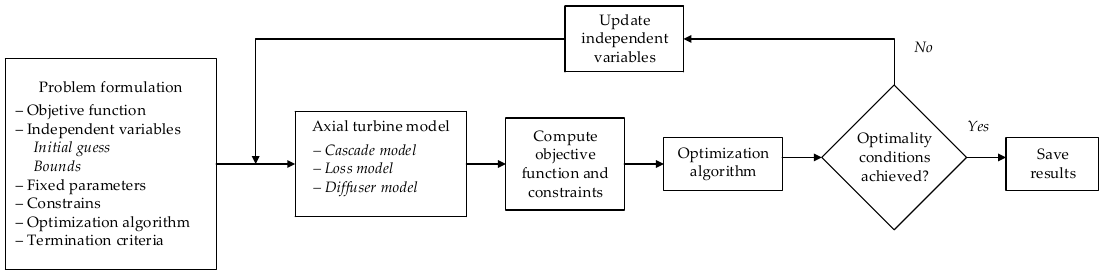
Figure 3. Axial turbine optimization strategy flow